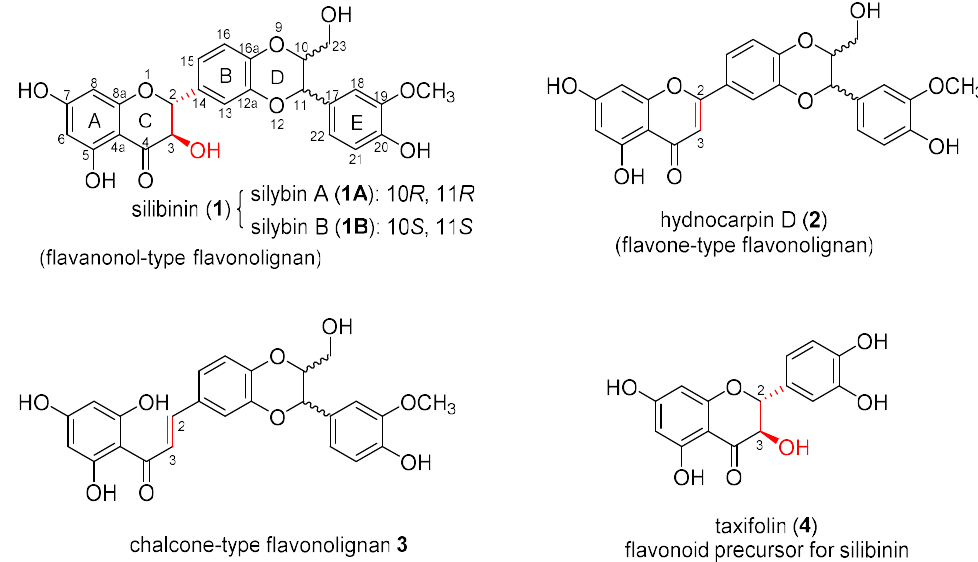
Figure 1. Structures of silibinin, hydnocarpin D, chalcone-type flavonolignan, and taxifolin.